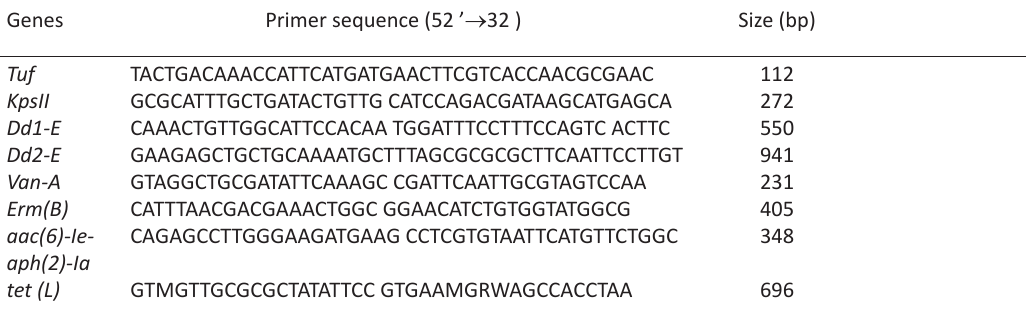
Fig. 2. Antimicrobial resistance profiles of nineteen multi-Drug resistance Enterococcus strains against sixteen Table 1. PCR primers for detection of some antibiotic resistance and virulence genes in Enterococcus spp. isolates